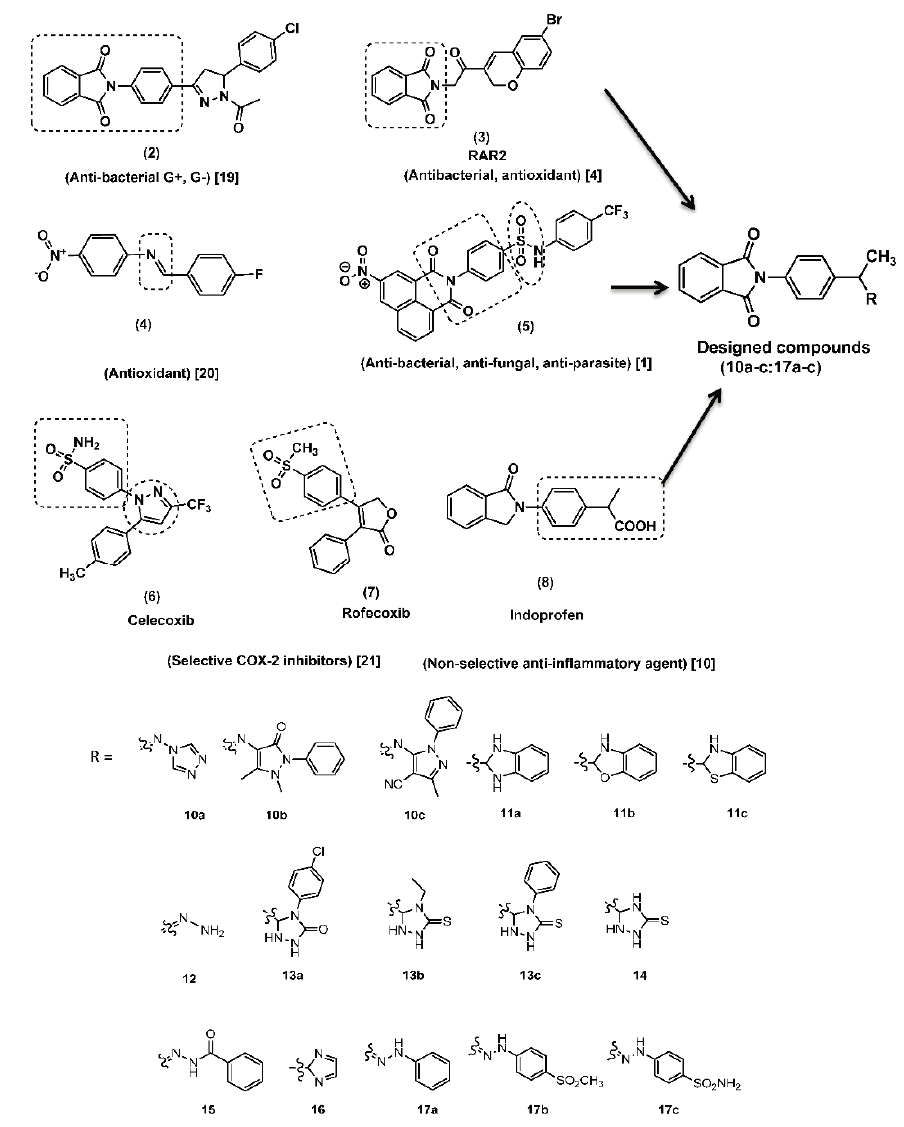
Figure 1. Representative examples of anti-microbial, anti-oxidant and anti-inflammatory agents and structural rationalization of the newly designed